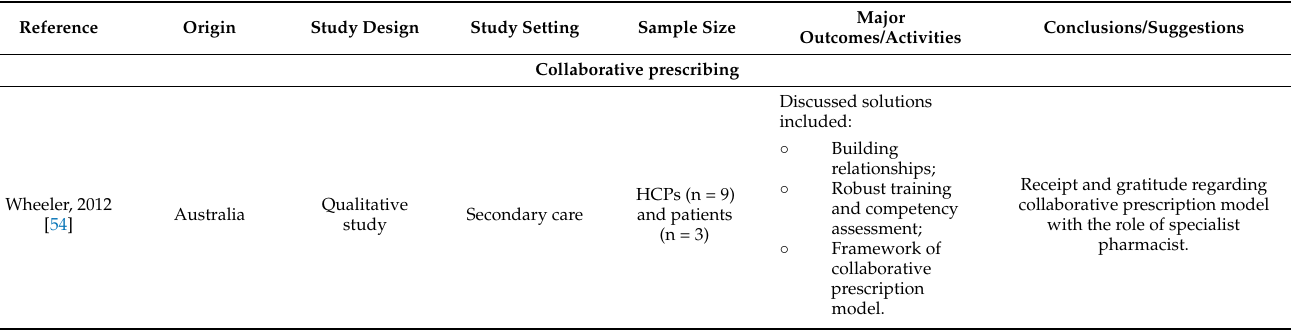
Table 4. Summary of studies’ characteristics (advanced